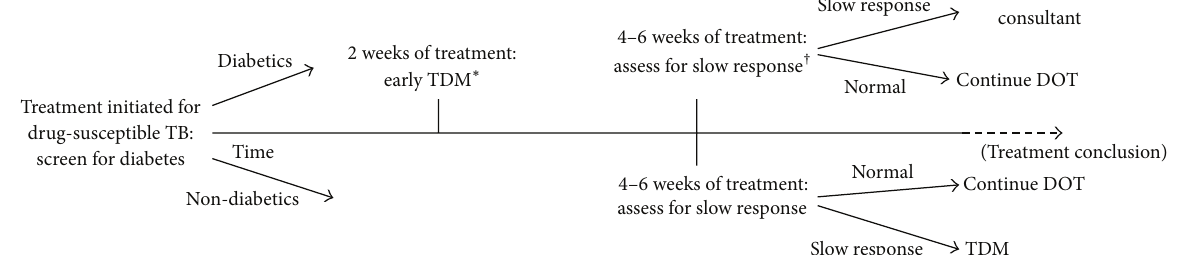
Figure 1: Statewide guidelines for the use of therapeutic drug monitoring (TDM). Diabetes identified by patient self-report or review or chart review by tuberculosis (TB) nurse case managers. ∗ TDM: an estimated peak concentration ( 𝐶 2 following directly observed therapy (DOT) and if below the expected range, then a single dose adjustment is made as per guidelines (e.g.,